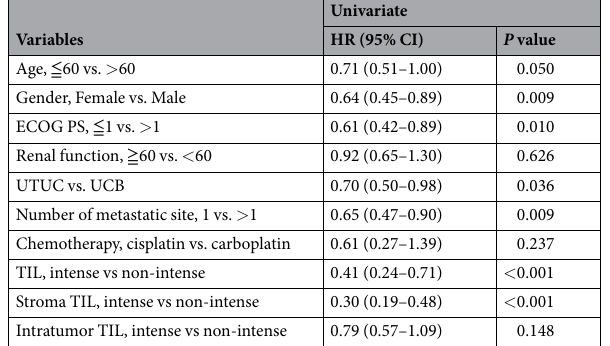
Table 2. Univariate Cox regression analysis of parameters associated with overall survival. ECOG PS = Eastern Cooperative Oncology Group performance status, UTUC = upper tract urothelial carcinoma, UCB = urothelial carcinoma of bladder, PUC = pure urothelial carcinoma, VUC = variant urothelial carcinoma, TIL = tumor- infiltrating lymphocyte, HR = hazzard ratio, CI = confidence interval.